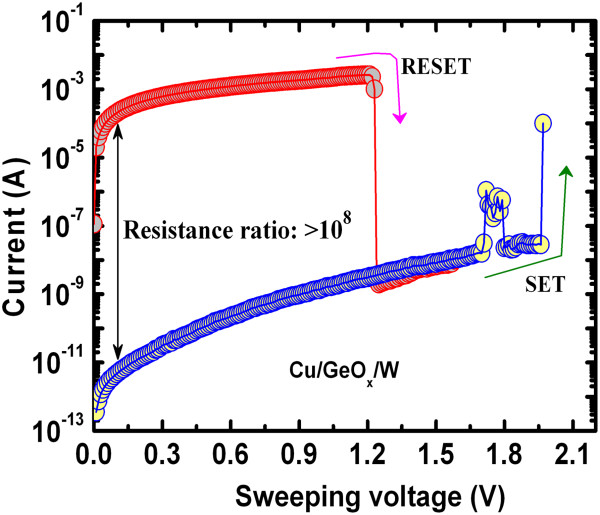
RESET current scalability comparison with Cu and Al electrodes. RESET currents versus CCs curve. The RESET current increases as the CCs for Cu TE increase; however, the RESET current is not scalable for Al TE because of the AlOx formation at the Al/GeOx interface.